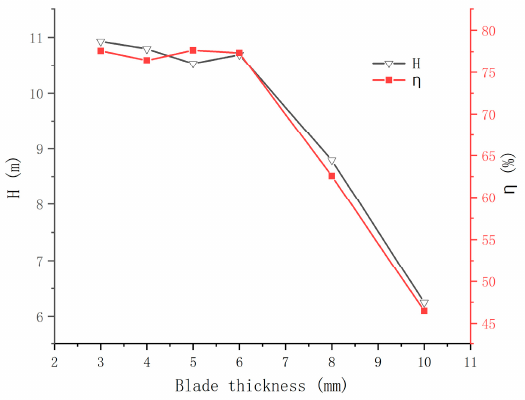
Figure 7. Pump performance of CTB.